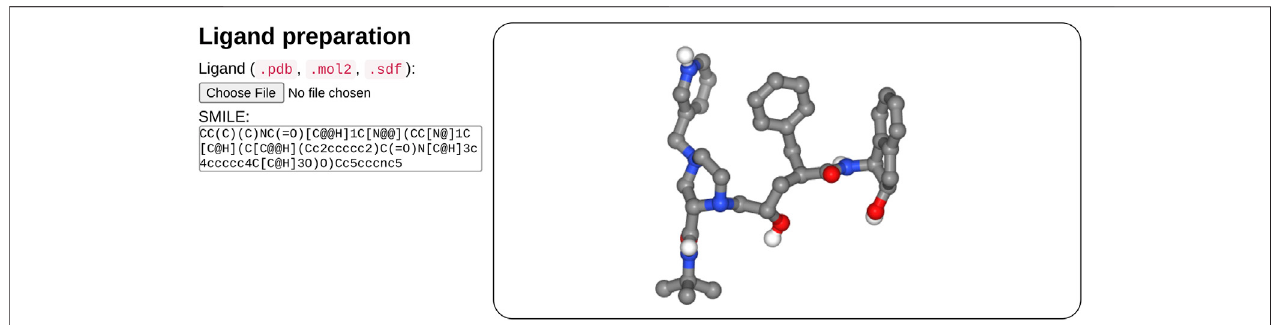
FIGURE 2 | Overview of the ligand input interface. SeamDock provides different options for ligand input. Users can provide ligand fi les of type pdb, mol2, or sdf, a SMILES speci fi cation can also be provided. Once the ligand structure has been prepared, its 3D structure will be displayed in a NGL stage.